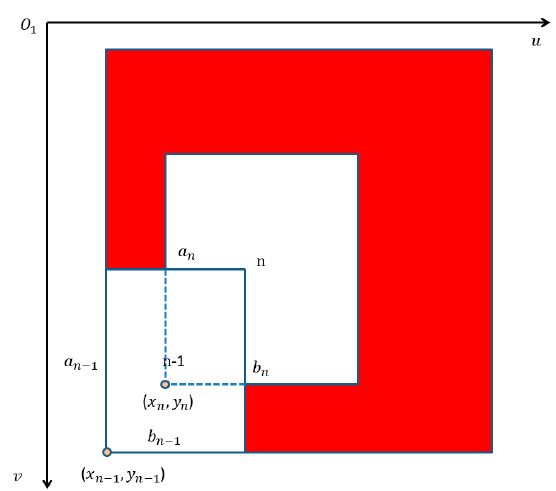
Figure 8. Red region of